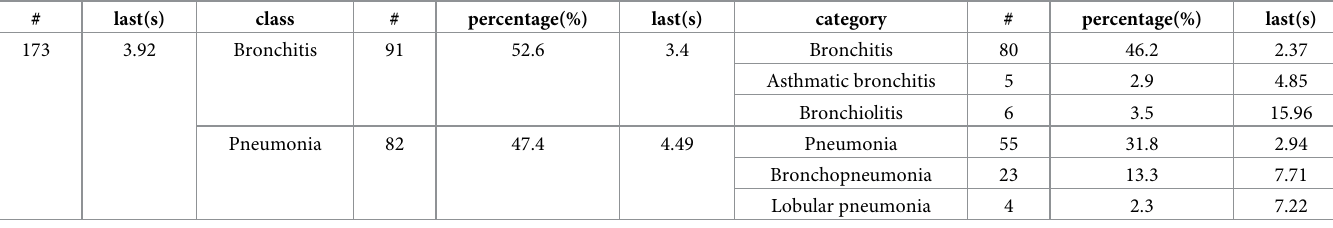
Table 2. Detailed statistics of patient audios collected in the hospital.